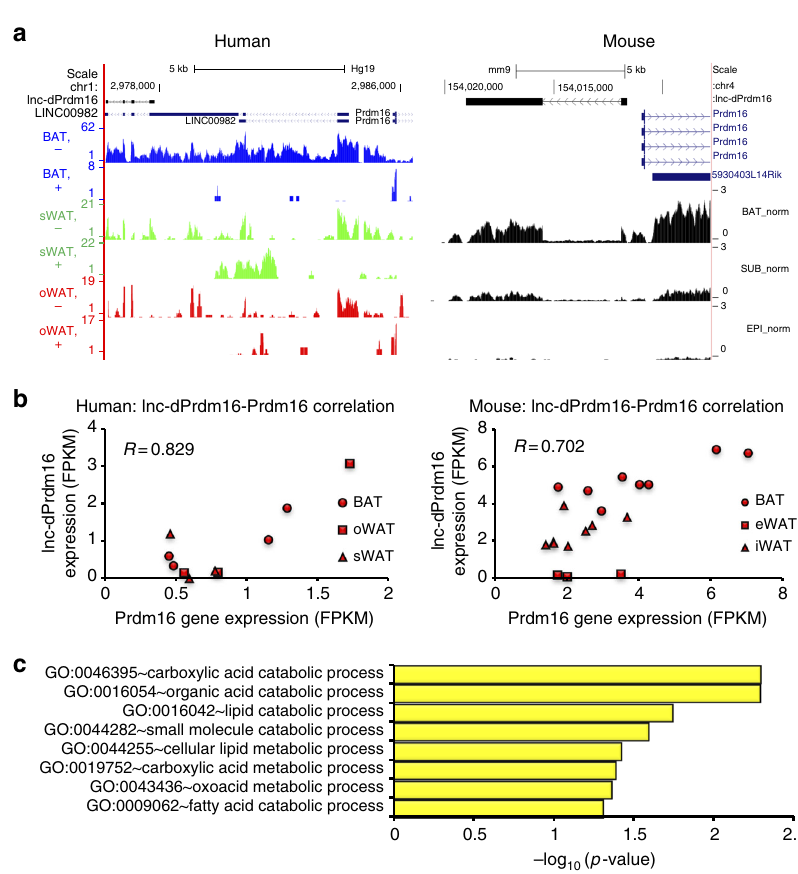
Fig. 7 lnc-dPrdm16 is predicted as a regulator in lipid metabolism. a Locus map depicting the relative location of lnc-dPrdm16 (corresponds to annotated LINC00982) to Prdm16 in human (left panel) and mouse (right panel). b Data points of gene expression of lnc-dPrdm16 and Prdm16 across different human (left panel) and mouse samples (right panel). c Top enriched GO terms for protein-encoding genes that are positively co-expressed with